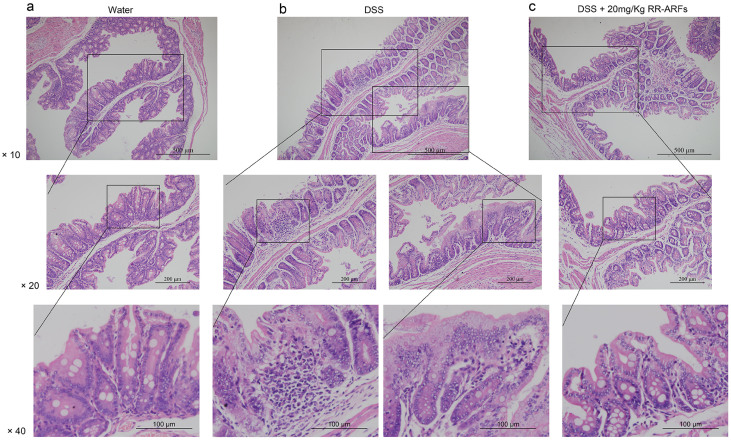
Effects of RR-ARFs on colorectal histology in mice with DSS-induced colitis.Histological changes were determined by hematoxylin and eosin staining. Water group showing normal histology of mice colon (a). Mucosal injury produced after DSS administration with distortion of crypts (b). DSS + 20 mg/kg RR-ARFs samples showing a reduction in the morphological alteration associated to DSS treatment (c).